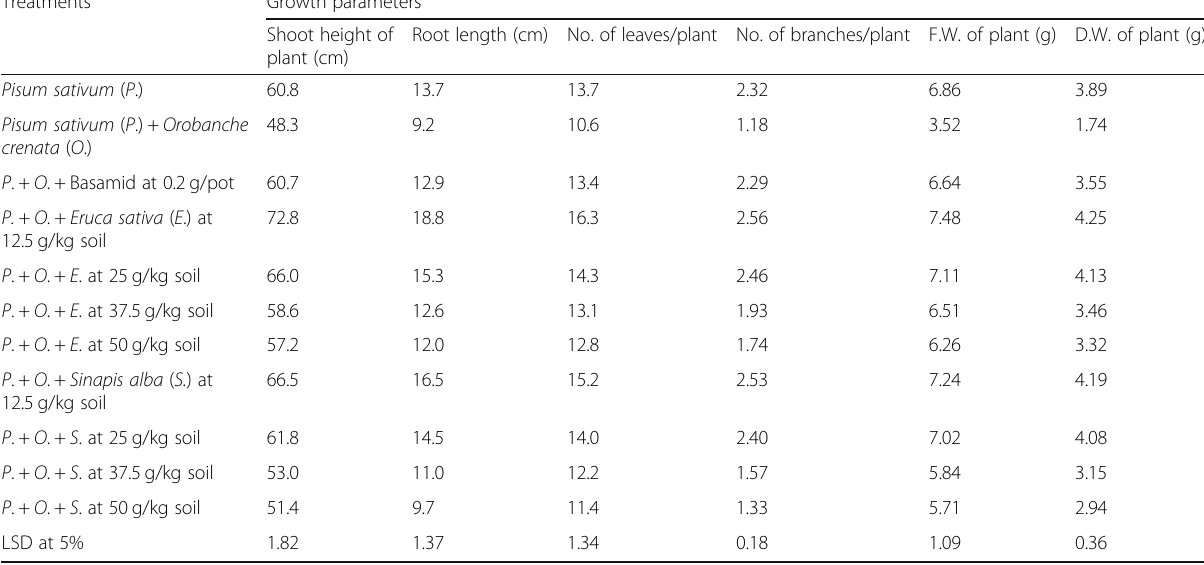
Quantitative estimation of total glucosinolates and total phenolic contents in Eruca sativa and Sinapis alba seed powder Table 6 shows the quantity of total glucosinolates (316.03 and 288.59 μ mol/g dry weight) and total phenolic contents (35.62 and 43.62 mg/g dry weight) in the seed powder of E. sativa and S. alba , respectively. Table 4 Effect of different rates of both Eruca sativa and Sinapis alba seed powder and herbicide Basamid on growth parameters of Pisum sativum at 90 days after sowing (combined analysis of two seasons) Treatments Growth parameters Shoot height of Root length (cm) No. of leaves/plant No. of branches/plant F.W. of plant (g) D.W. of plant (g) plant (cm) Pisum sativum ( P